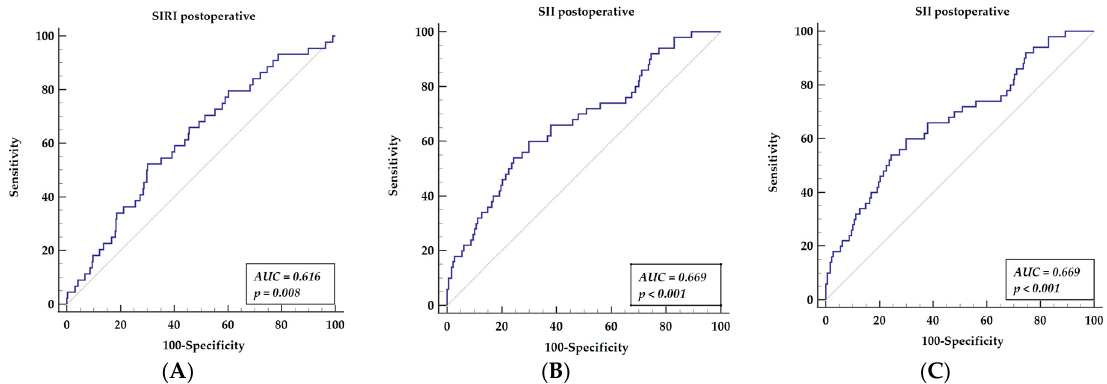
Figure 1. Receiver operator characteristics curves for postoperative SIRI ( A ), postoperative SII ( B ), and postoperative AISI ( C ). Abbreviations: AISI—aggregate index of systemic inflammation, AUC—area under the curve, SII—systemic inflammatory index, SIRI—systemic inflammatory response index.